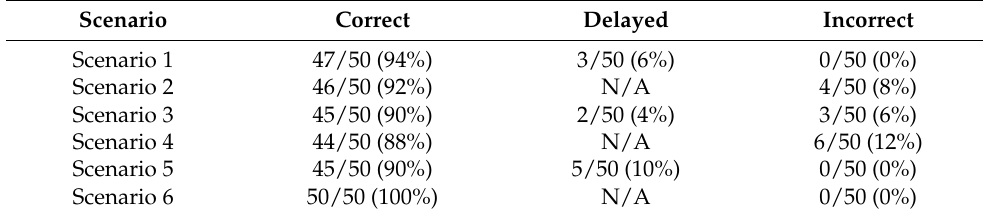
Table 6. Experimental results of 300 repetitions across all six testing